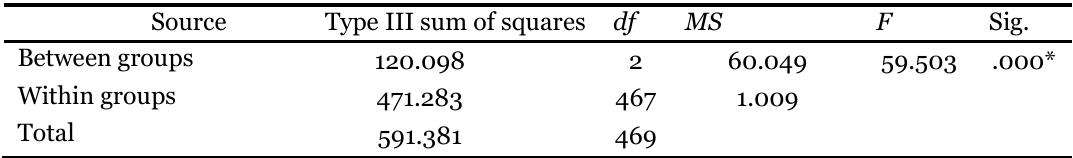
One-Way ANOVA Results of Parents’ Perceptions Toward the Distance Learning Process According to School Type Variable Source Within groups